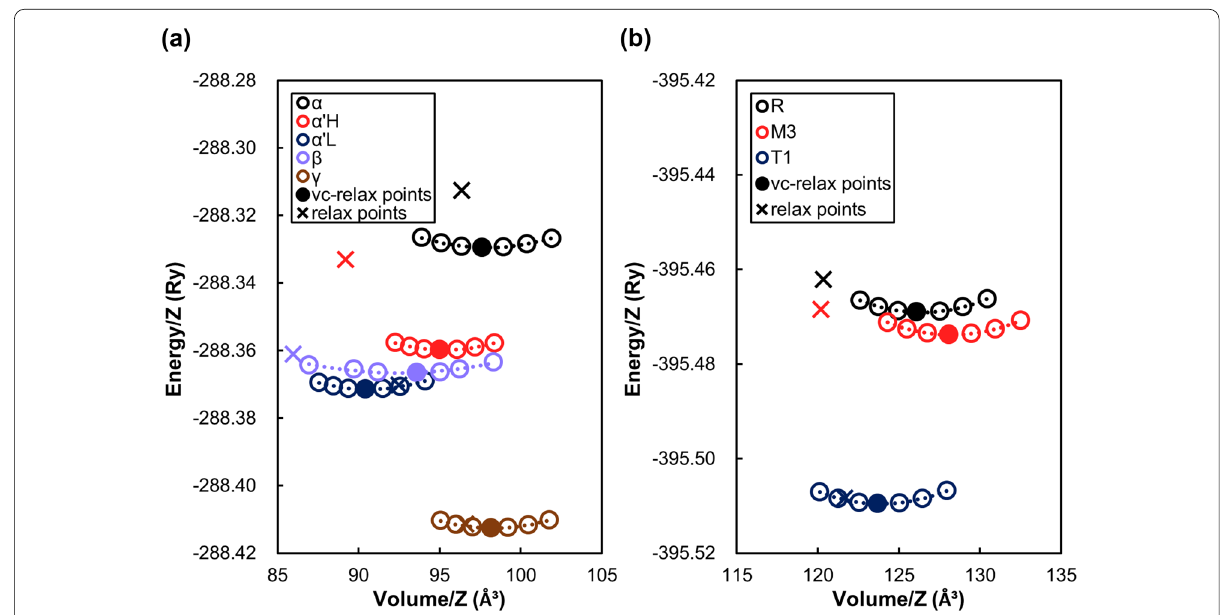
Fig. 2 Energy variation of polymorphs of a belite and b alite